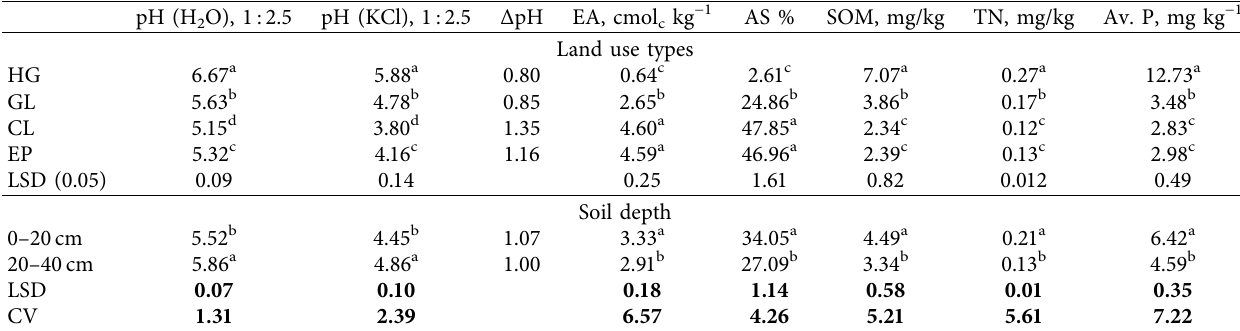
Table 1: Main efects of land use and soil depth on soil pH (H the soils in the Hojje watershed ( N � 24).